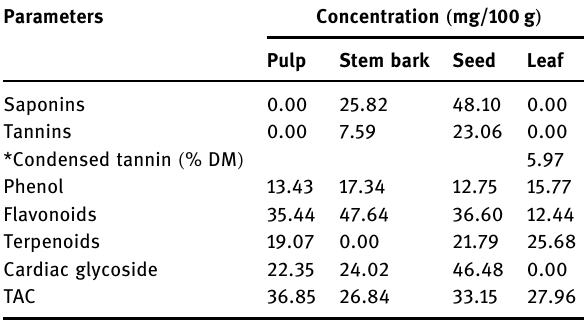
Table 5: Phytochemical content and total antioxidant capacity ( TAC ) of various parts of D. guineense